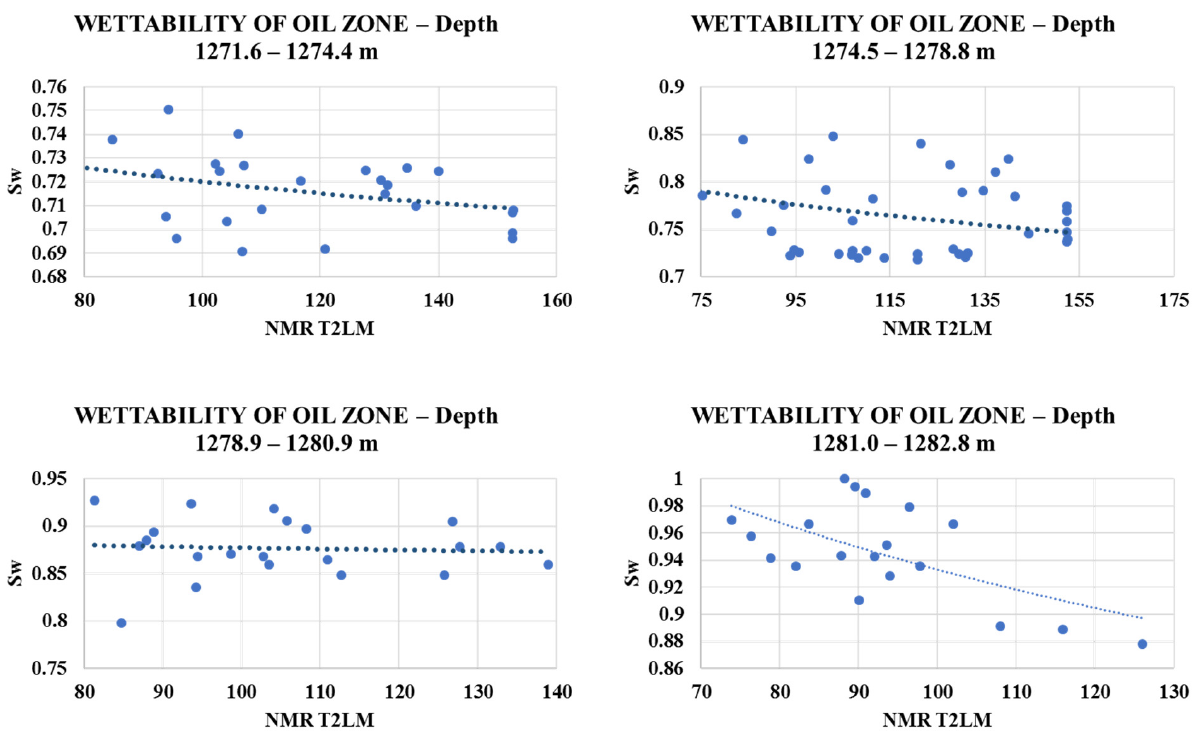
Figure 9. Cross-plot correlation between water saturation and NMR T 2 LM showing the trends for oil and gas zones.